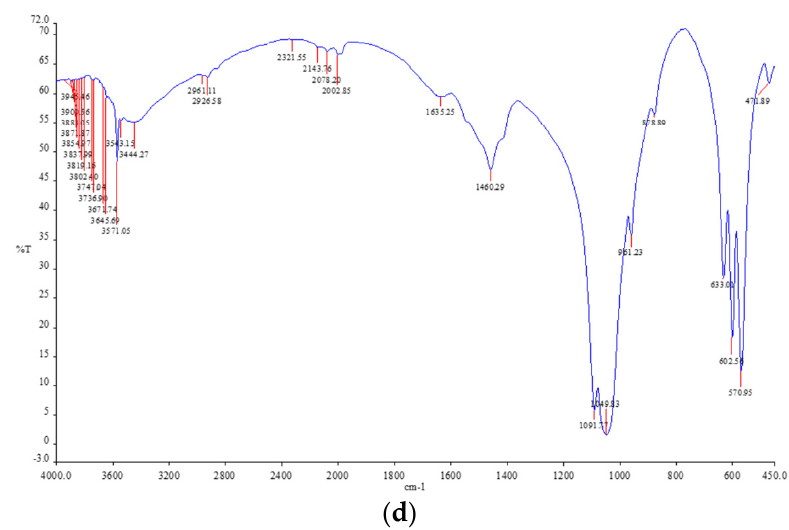
Figure 1. ( a ) Representative of SEM Scanning Result of BHA–GEL Pellet; ( b ) FT-IR Spectra Profile of BHA ( c ) FT-IR Sepctra Profile of Gelatin; ( d ) FT-IR Spectra Profile of BHA–GEL Pellet.